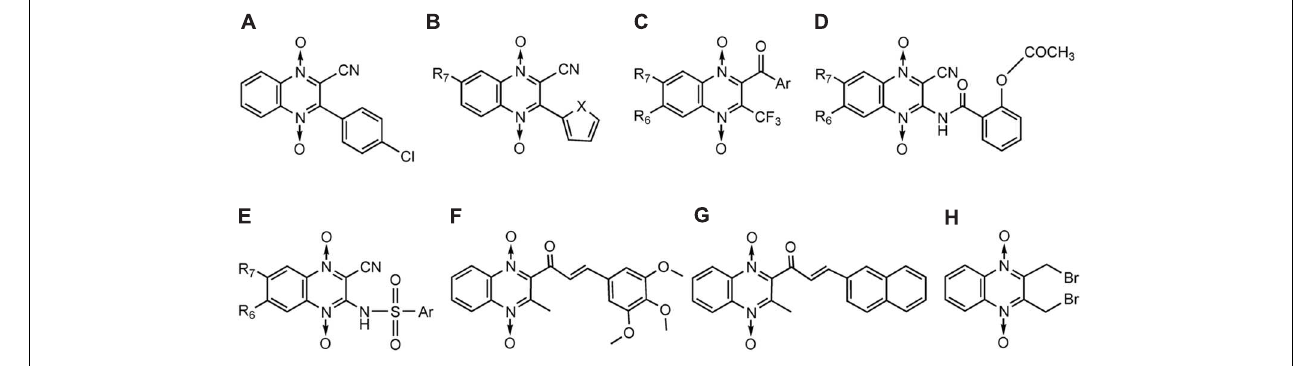
FIGURE 9 | QdNOs with antimalarial activity.